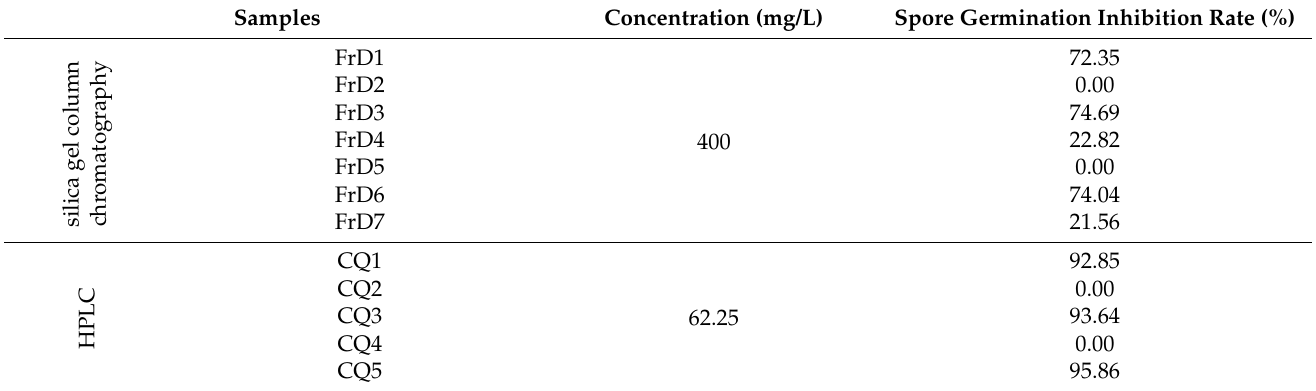
Table 6. Spore germination inhibition rate of 7 fractions of CX extract obtained by silica gel column chromatography and 5 fractions obtained by HPLC on Botrytis cinerea